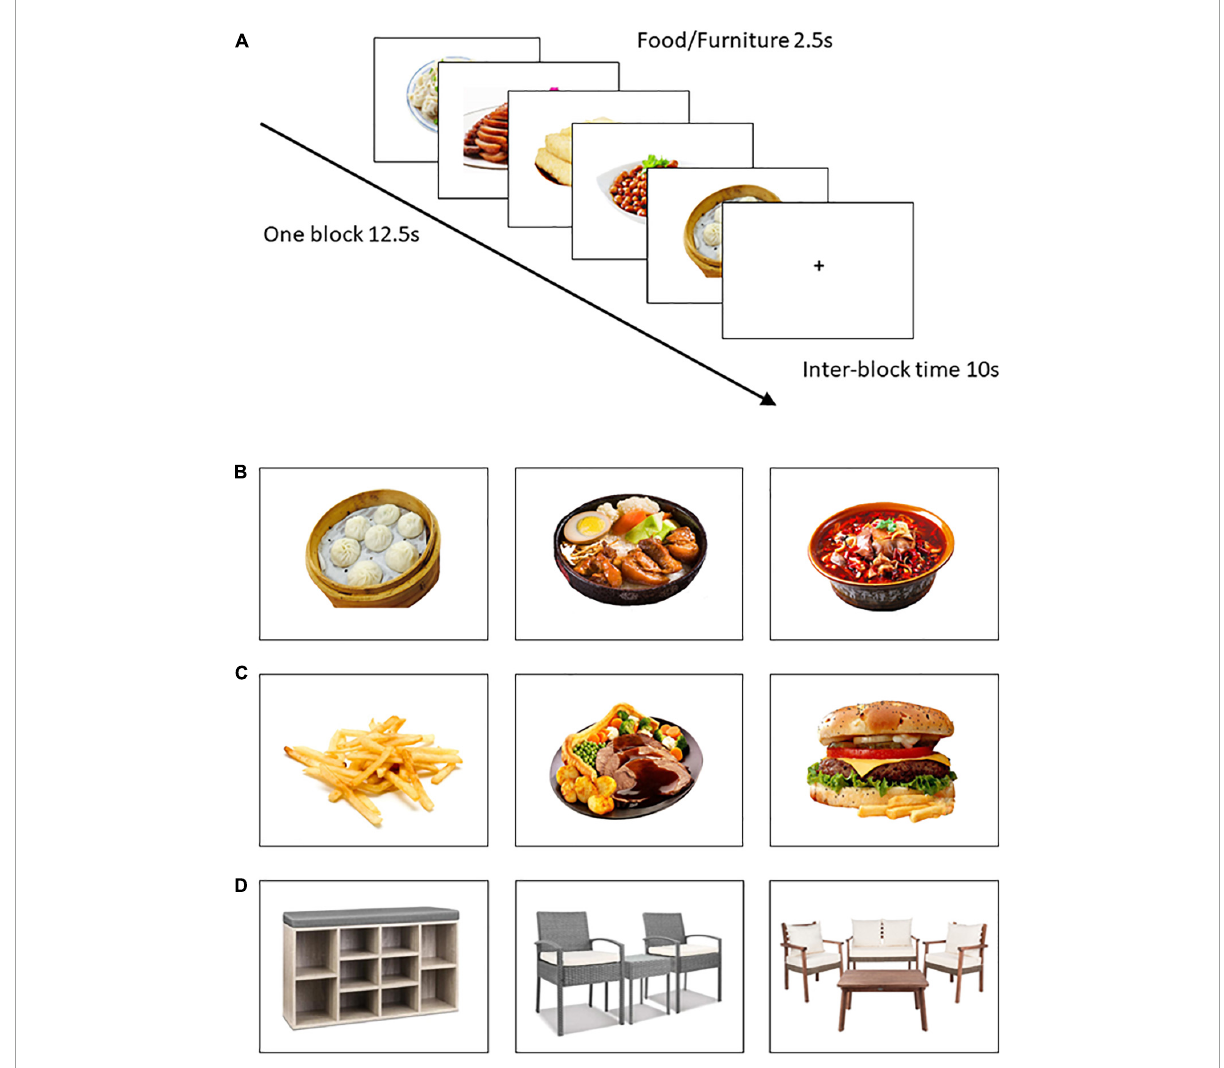
FIGURE1 Examples of image types and the sequence of events in each task trial. (A) Depicted is one Chinese food block; (B) Chinese food (ChFd); (C) Western food (WeFd); (D) Furniture